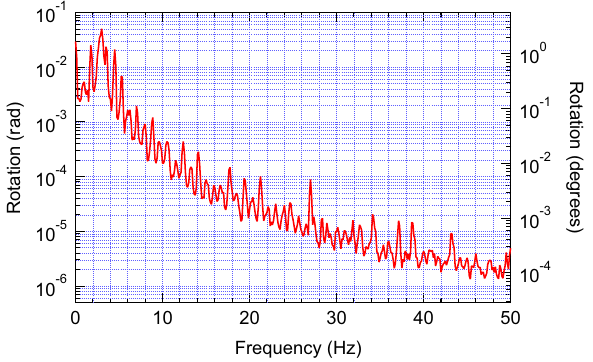
Fig. 14 Demodulated rotation spectrum obtained with the quarter- wave plate inserted in the scheme of Fig. 3b and the half-wave plates rotating at ν P = 6 . 5 Hz. Integration time 8 s, Hanning window. The rms rotation value is ≈ 5 ◦